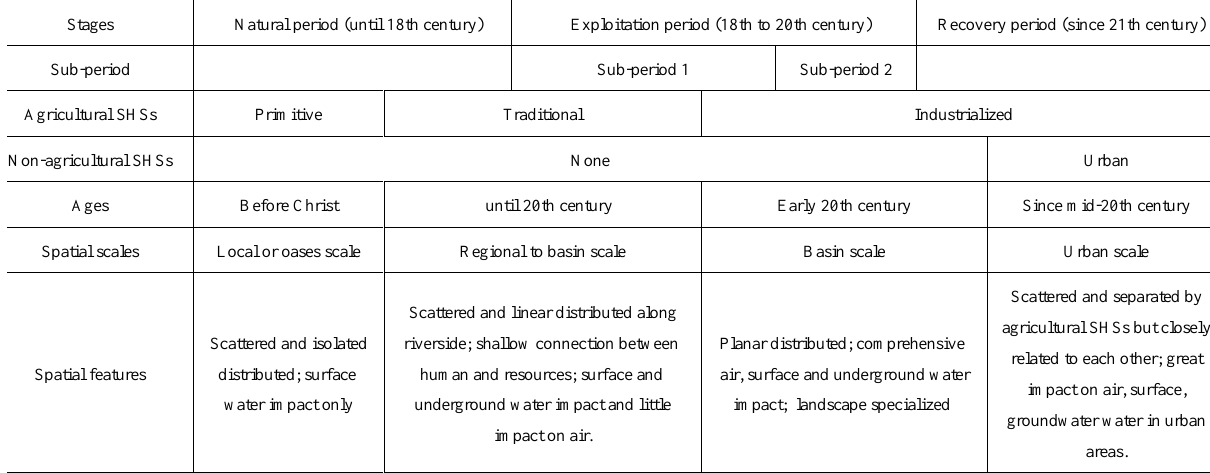
Table 1. Spatial features and the ages of four types of socio-hydrological systems (SHSs): the ages of the four types of SHS do not strictly match the human development stages because the latter are divided on the basis of human–water relationships and dominant factors